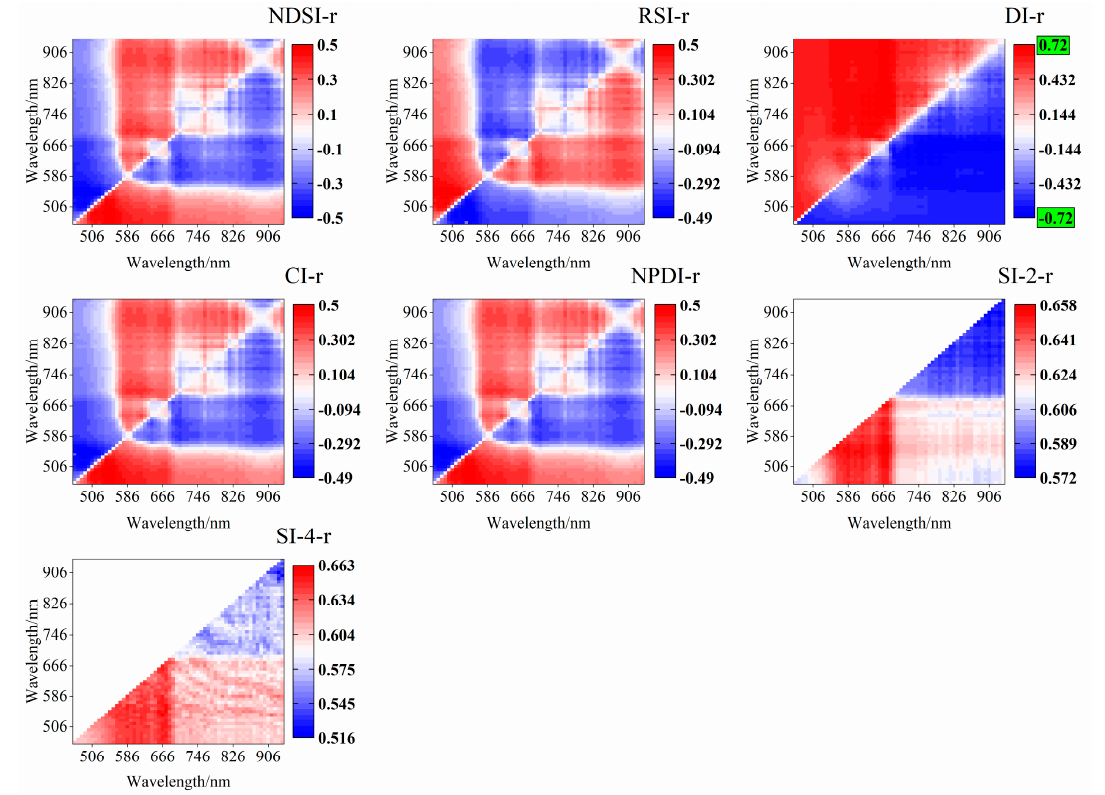
Figure 13. Two-dimensional r diagram between SMC and 0.5-order absorbance spectrum.